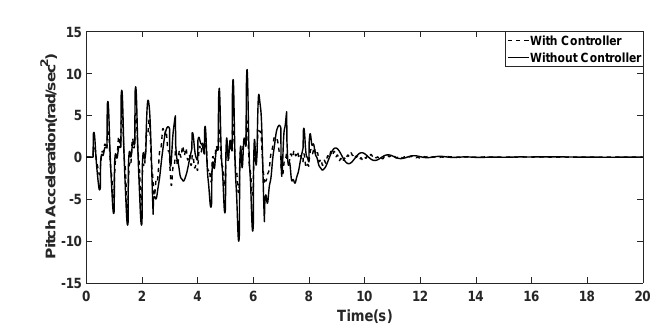
Figure 12. Pitch Acceleration.